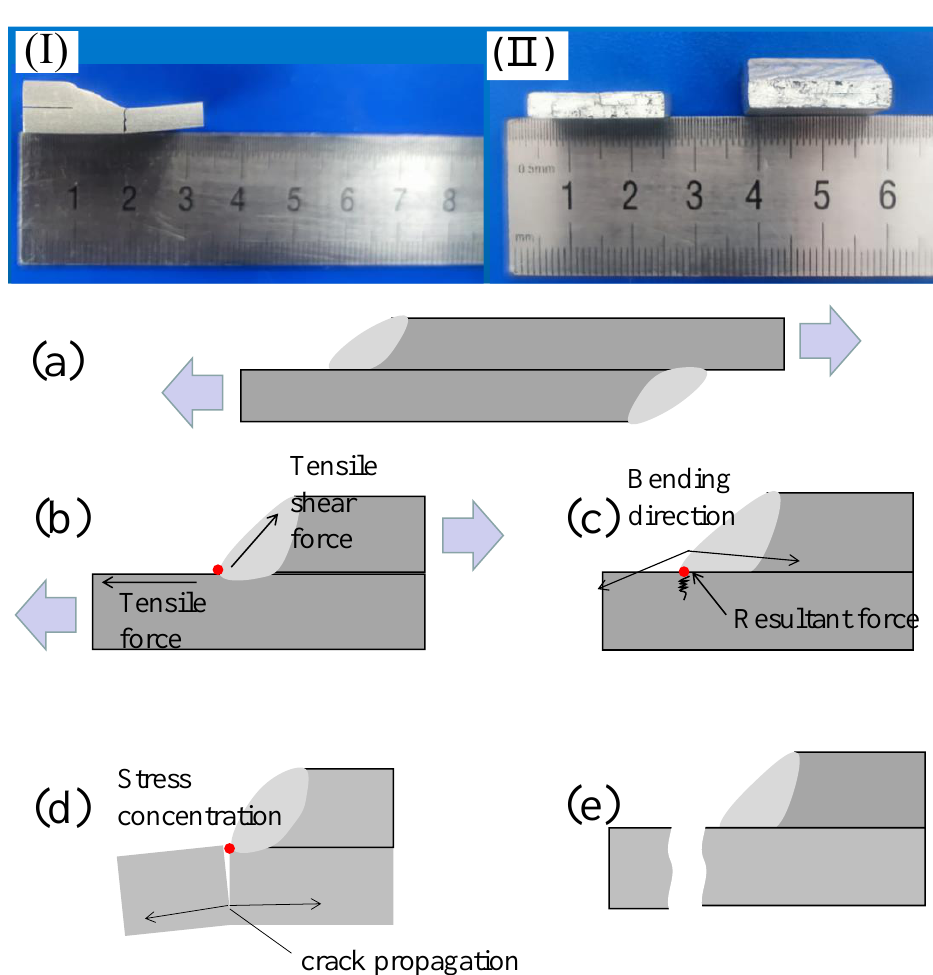
Figure 6. Stress concentration fracture mechanism of lap joint: ( I ) fracture location, ( II ) fracture morphology, ( a ) fatigue specimen and loading direction, ( b ) stress distribution at weld toe, ( c ) stress concentration and sample bending, ( d ) crack propagation, ( e ) specimen fracture.